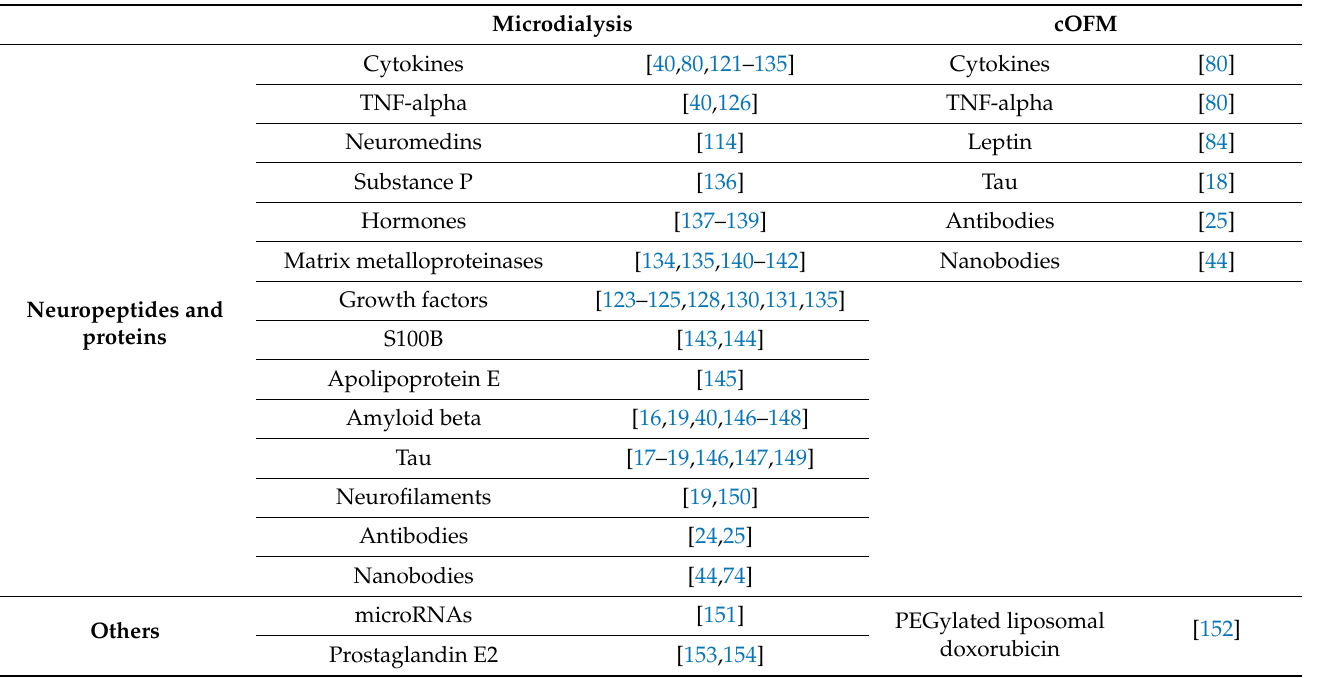
Table 2. Examples of macromolecules sampled from the cerebral interstitial fluid. Microdialysis